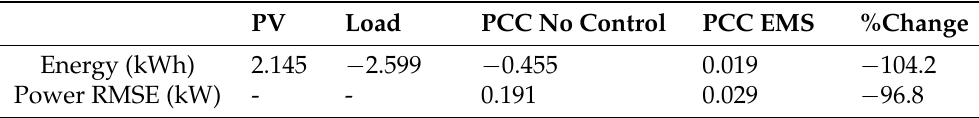
Figure 4. PCC test results. Positive and negative signs indicate the direction of PCC power exchange, import to the MG, and export from the MG, respectively. Table 2. Comparison between base scenario and MQTT-based